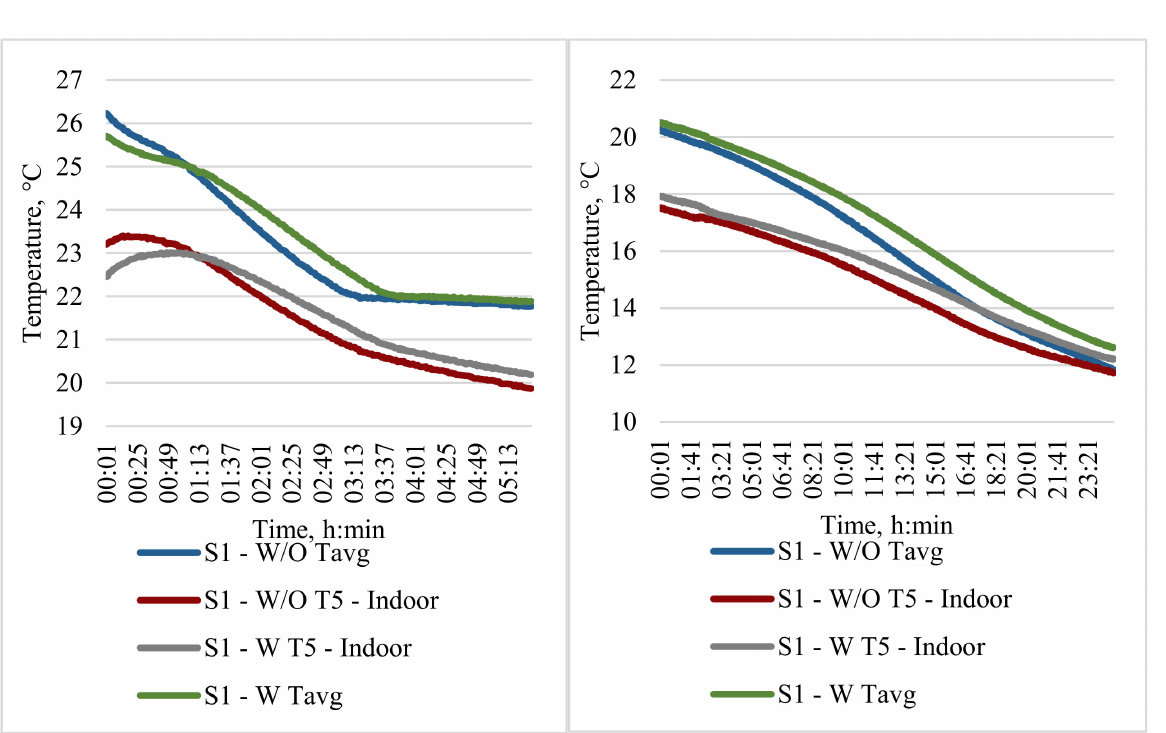
Figure A1. ( Left ) Close-up of average PCM temperature and “indoor” temperature at the beginning of the discharging phase where, after losing sensible heat, PCM entered a phase of discharging latent heat. With an adjusted layer of insulation, cooling is at a slower rate, and PCM enters the solidification phase at a later point in time. ( Right ) Close-up of the average PCM temperature and indoor temperature at the end of the charging—discharging cycle. With an adjusted layer of insulation, the average temperature in PCM is 0.5 ◦ C higher and the temperature in the “indoor space” is 0.9 ◦ C higher than in the sample without an adjustable insulation